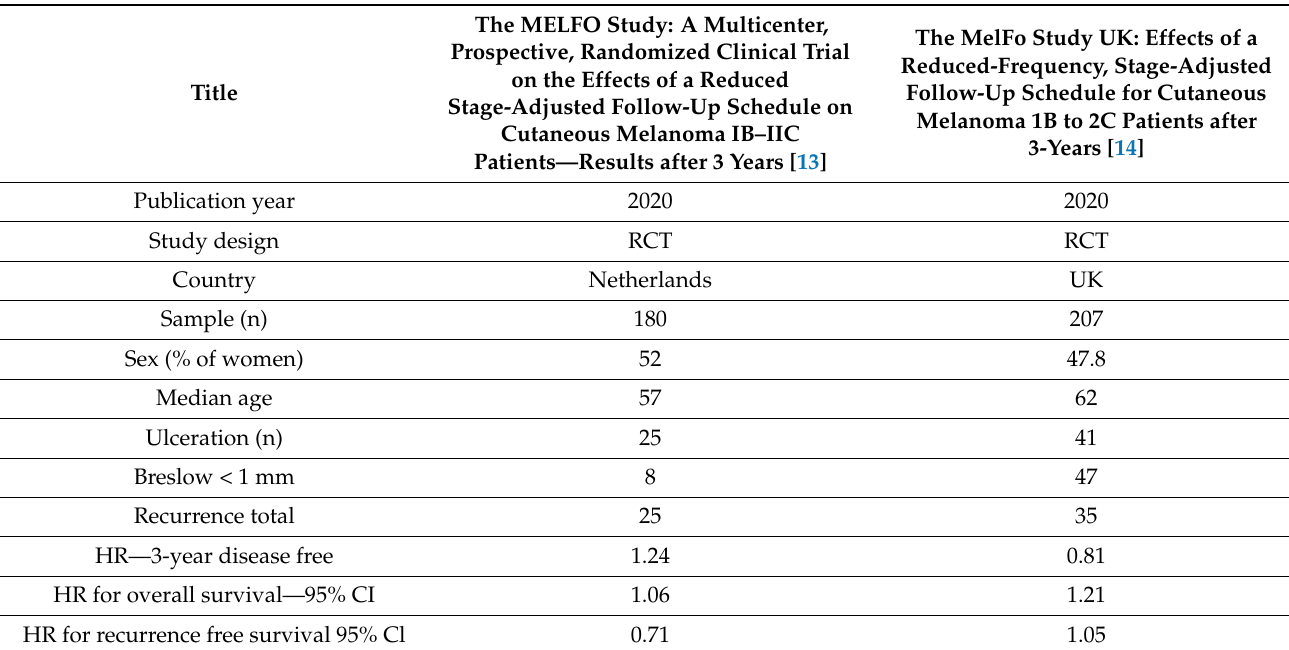
Table 1. Characteristics of included